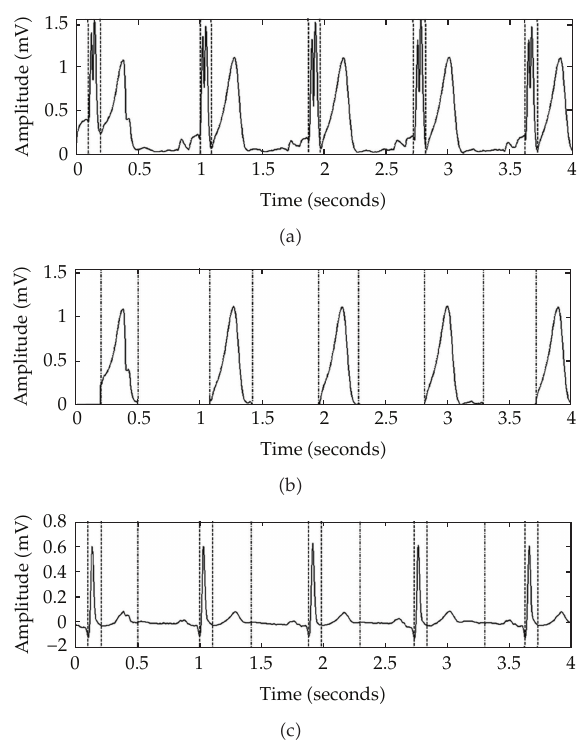
Figure 3: Detection of the QRS complex (cid:2) depicted by the dashed line (cid:3) and T wave (cid:2) depicted by the dashed dotted line (cid:3) . (cid:2) a (cid:3) the detected QRS complex region on the magnitude of the dVCG signal, (cid:2) b (cid:3) the detected T wave region, (cid:2) c (cid:3) the detected QRS complex and T wave region on the signal of lead II.